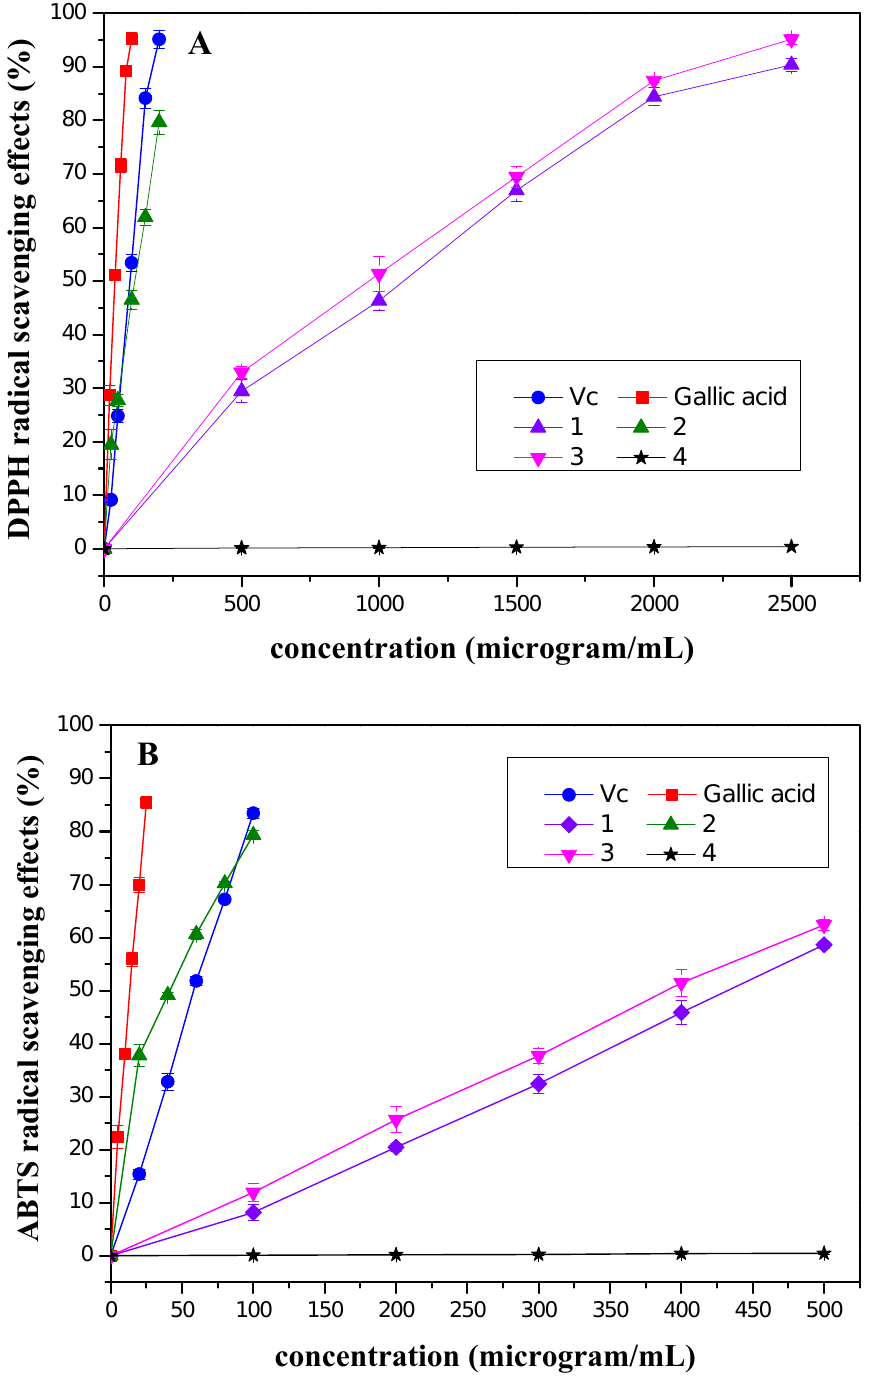
Figure 3. Scavenging activities of different concentrations of 1 - 4 isolated from Microcos paniculata towards (A) DPPH, (B) ABTS and (C) hydroxyl radicals. Free-radical- scavenging activities were indicated as % inhibition. Each point was performed as mean ± standard deviation (SD) of three